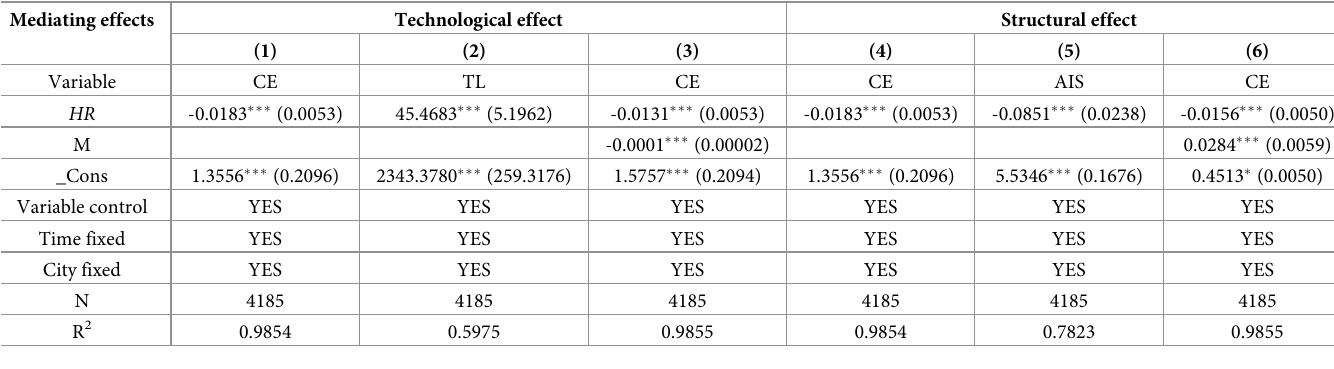
Table 7. Indirect transmission